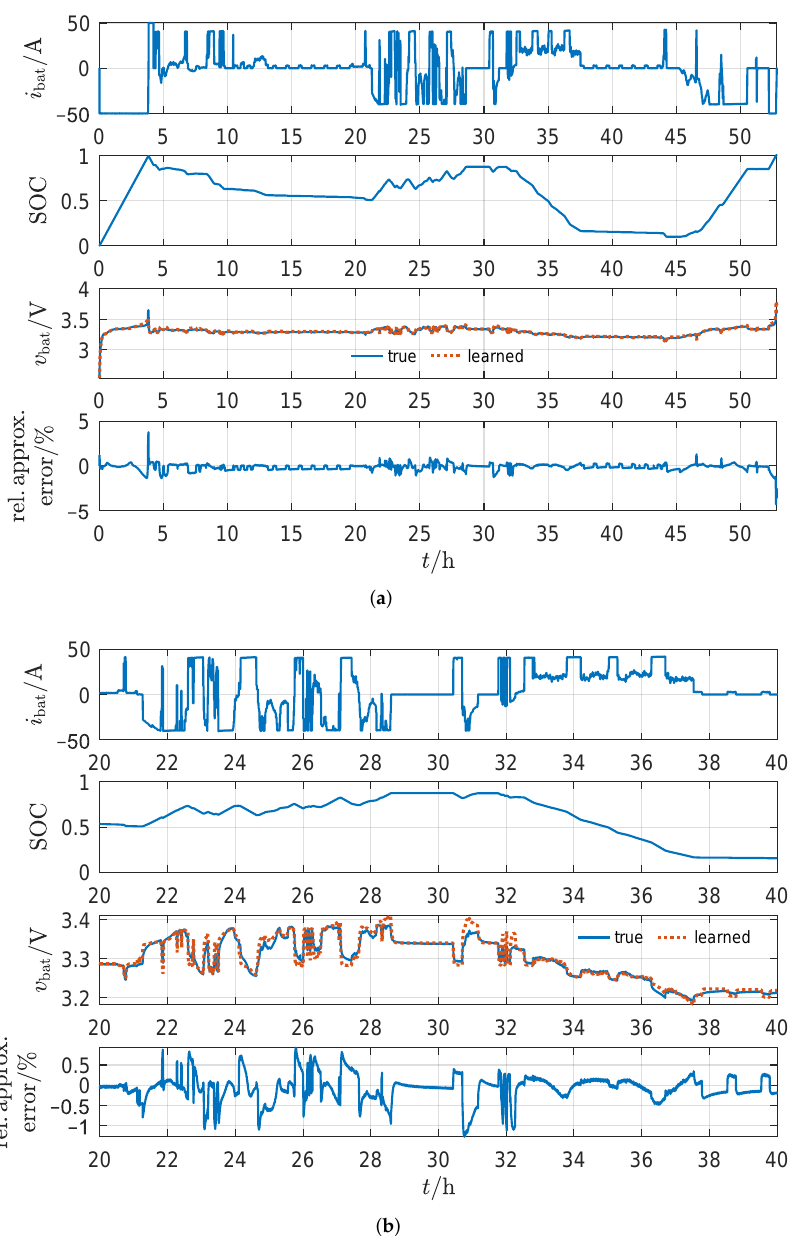
Figure 9. Test results in comparison to experimental data at T = 25°C for a synthetic load profile; ( a ) the complete time series ( b ) focus on the segment in the